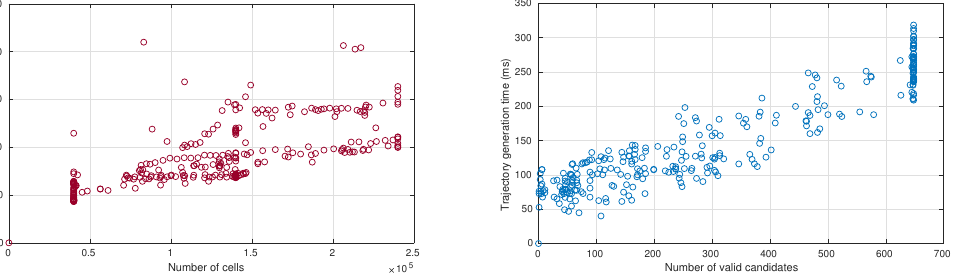
( b ) Candidate generation time for simulation environment.